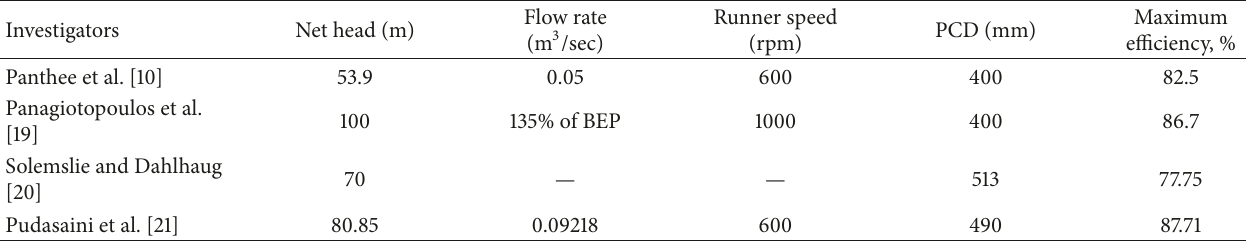
Table 1: Some Pelton turbine studies and maximum efficiency levels attained.